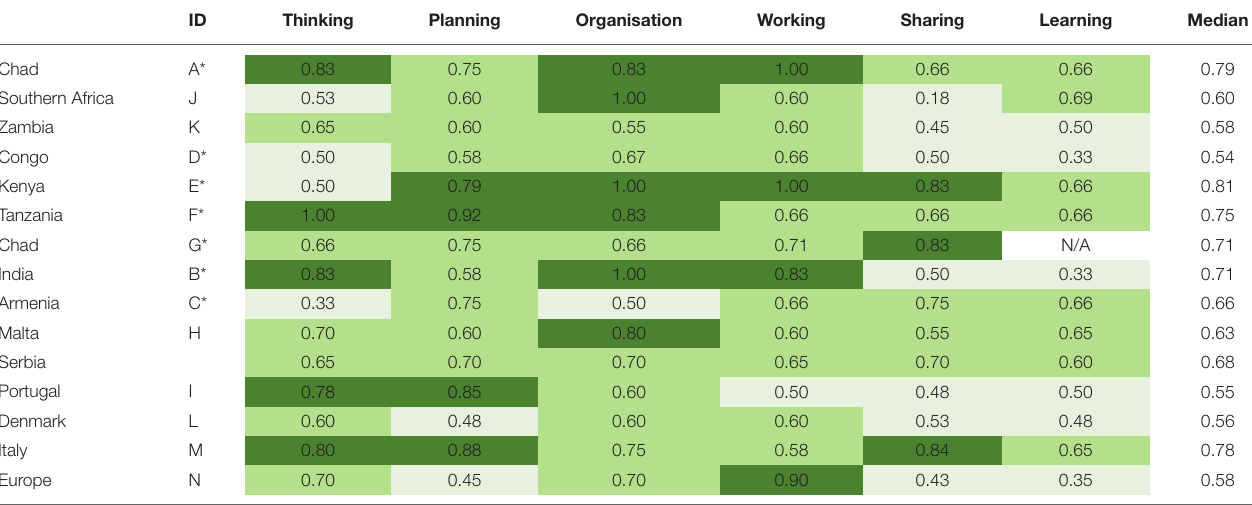
TABLE 4 | Aspect scores computed for the 15 case studies using the EVOLvINC tool. ID Thinking Planning Organisation Working Sharing Learning